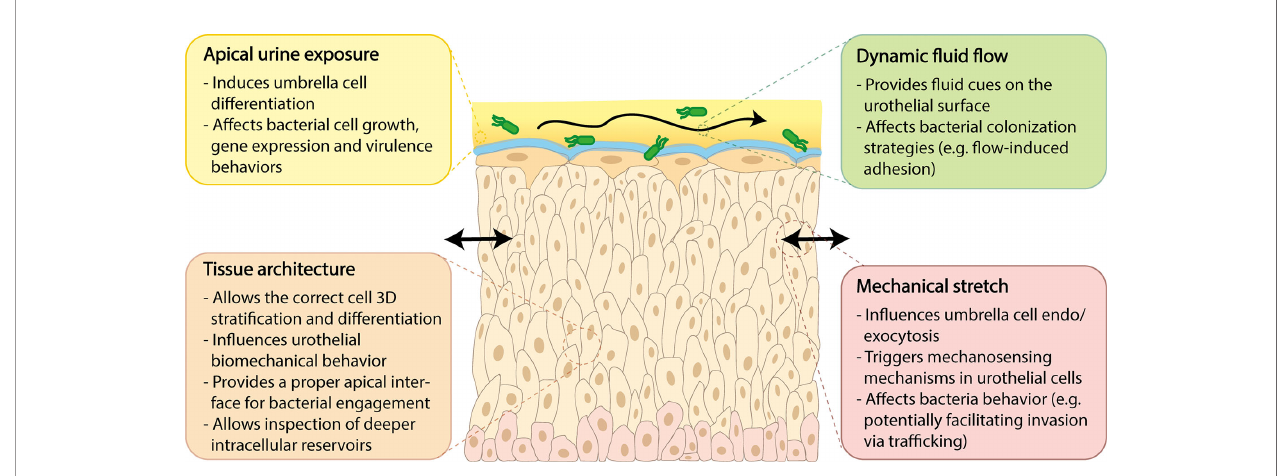
FIGURE 3 | Key features required for advanced human urothelial models and their importance for